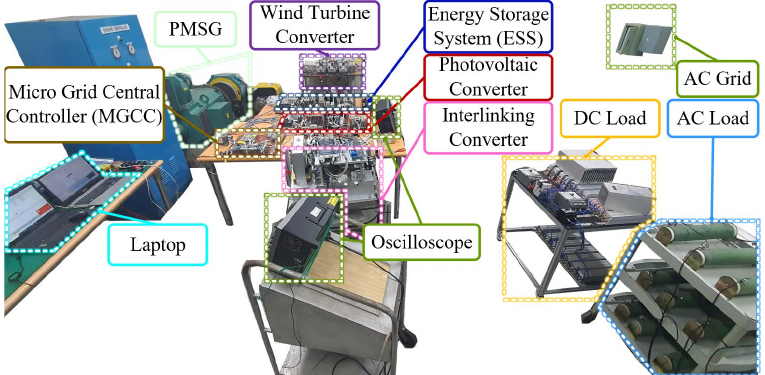
Energies 2023 , 16 , x FOR PEER REVIEW Figure 15. Small scale microgrid experiment al equipment. Figure 15. Small scale microgrid experimental equipment. Figure 15. Small scale microgrid experiment al equipment.